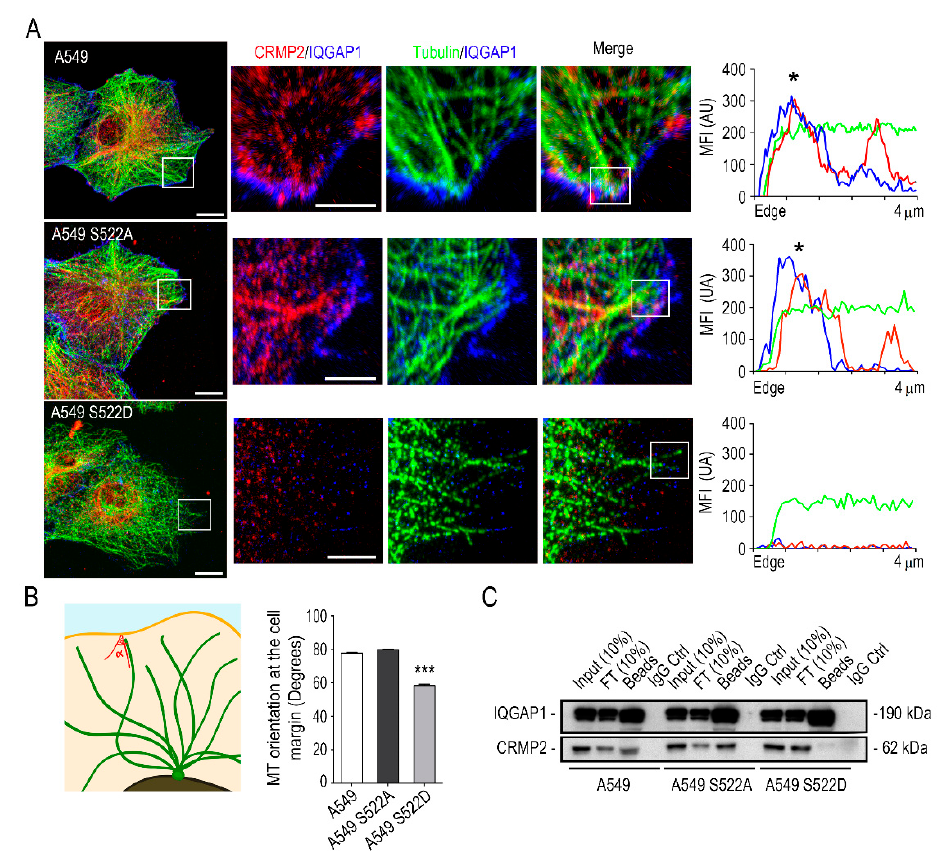
Figure 7. CRMP2 interacts with IQGAP1 at the membrane edge. ( A ) Representative confocal images of maximum intensity projections in the control cell line A549 and in the CRMP2 clones migrating towards CCL21 gradients (200 ng/mL) after being stained with tubulin (green), CRMP2 (red), and IQGAP1 (blue). Scale bar = 10 microns. White insets show enlarged areas of the microtubule docking regions at the cell membrane. Scale bar = 5 microns. Representative fluorescence intensity profiles on the right show the localization of CRMP2 and IQGAP1 (black asterisks) signals in the first 4 microns of the +TIP of a single microtubule; ( B ) quantification of microtubule-membrane contact angle from images shown in ( A ). (Number of microtubules, n = 450). The schematic representation on the left shows the strategy followed to measure the MT-cell membrane contact angle; ( C ) immunoprecipitation of CRMP2 and IQGAP1 proteins from extracts obtained from A549 wild-type and A549 cells expressing the CRMP2 mutants. (Number of blots, n = 3). *** ( p < 0.001).